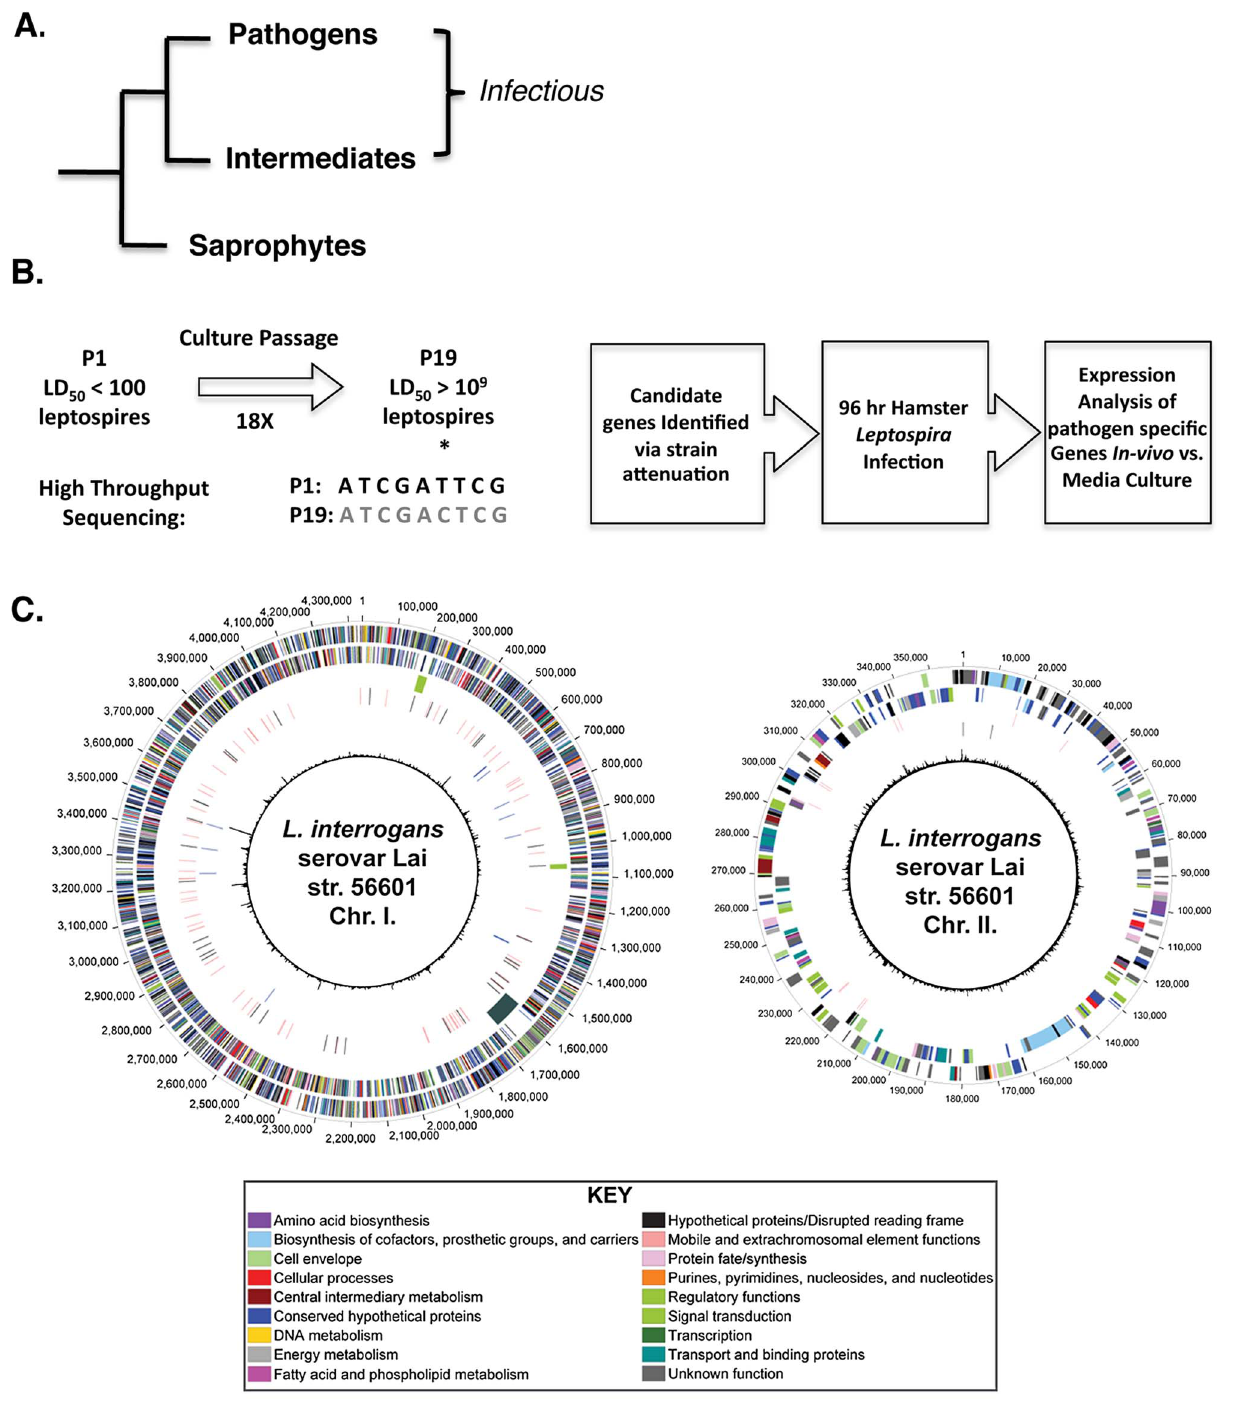
Figure 1. Pathogenomic analysis of Leptospirainterrogans serovar Lai strain 556021 to identify virulence related genes. ( A ) Schematic of phylogenetic relatedness of ‘‘Pathogenic’’ (P), ‘‘Intermediate’’ (I) and ‘‘Saprophytic’’ (S) members of the genus Leptospira . ( B ) Workflow to identify putative virulence-associated genes. Asterisk denotes a hypothetical position in which a SNV has been identified ( C ) Genomic Locations of SNPs and PF07598 paralogs in the reference genome of L. interrogans serovar Lai strain 56601. Each concentric circle represents genomic data and is numbered from the outermost to the innermost circle. The outermost circles represent the predicted CDS on the + and 2 strands, respectively, colored by functional role categories (see key). The following circle descriptions apply to chromosome I. The third circle notes the location of predicted prophage regions (olive) and the LPS region (slate). The fourth circle indicates those CDS found to have non-synonymous amino acid substitutions (black) as well as the location of CDS annotated as ‘‘transposase’’ in Genbank (salmon). The fifth circle represents the location of the 12 PF07598 family members (blue). The innermost circle denotes atypical regions ( x 2 value). For chromosome II, the outermost and innermost circles are the same as for chromosome I; however, the third circle notes the location of transposases (salmon), while the fourth circle indicates the location of the CDS found to have non-synonymous amino acid substitutions (black). doi:10.1371/journal.pntd.0002468.g001 PLOS Neglected Tropical Diseases |